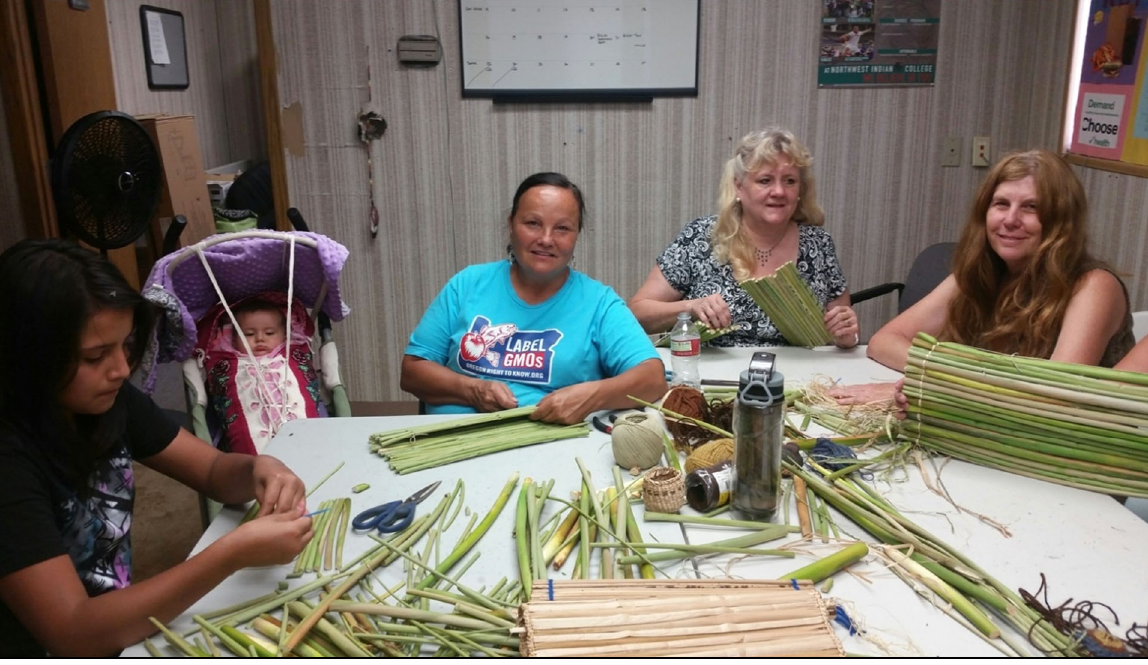
Figure 4. Women Weaving Tule Mats at a Workshop in the Upper Klamath River